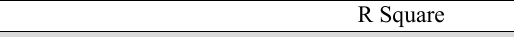
R Square R Square R Square Adjusted PI 0.595 0.566